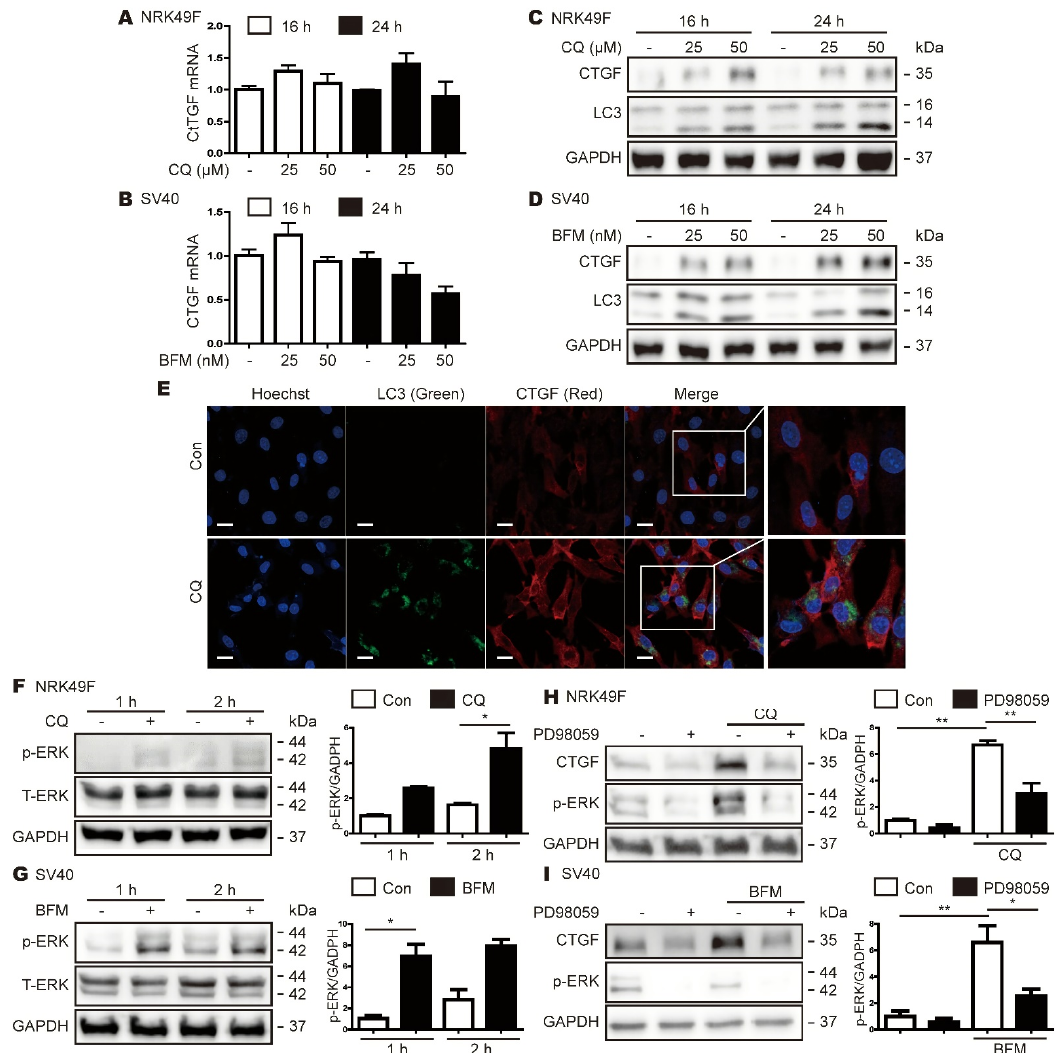
Figure 6. Inhibition of autophagy increased p-ERK and CTGF expression in kidney cells. NRK49F cells were treated with 25 or 50 µM CQ for 24 h, and SV40 MES 13 cells were treated with 25 or 50 nM BFM for 16 or 24 h. ( A , B ) Real-time RT-PCR analyses of CTGF mRNA expression in CQ-treated NRK49F cells ( A ) and BFM-treated SV40 MES 13 cells ( B ). ( C , D ) Western blot analyses showing the effects of CQ and BFM on CTGF and LC3 expression in NRK49F ( C ) and SV40 MES 13 ( D ) cells. ( E ) IF analyses showing the colocalization of CTGF (red) with LC3 (green) in AML12 cells in the presence or absence of CQ. ( F , G ) Western blot analyses showing the effects of CQ and BFM on p-ERK and total ERK (T-ERK) expression levels in NRK49F ( F ) and SV40 MES 13 ( G ) cells, respectively. The data in the bar graphs represent the mean ± SEM of three independent measurements; * p < 0.05. ( H , I ) Western blot analyses showing the effects of PD98059 (40 µM) on CQ- or BFM-induced CTGF expression. NRK49F cells were incubated with CQ for 24 h ( H ), and SV40 MES 13 cells were incubated with BFM for 24 h ( I ). The data in the bar graphs represent the mean ± SEM of three independent measurements; * p < 0.05, ** p < 0.01.